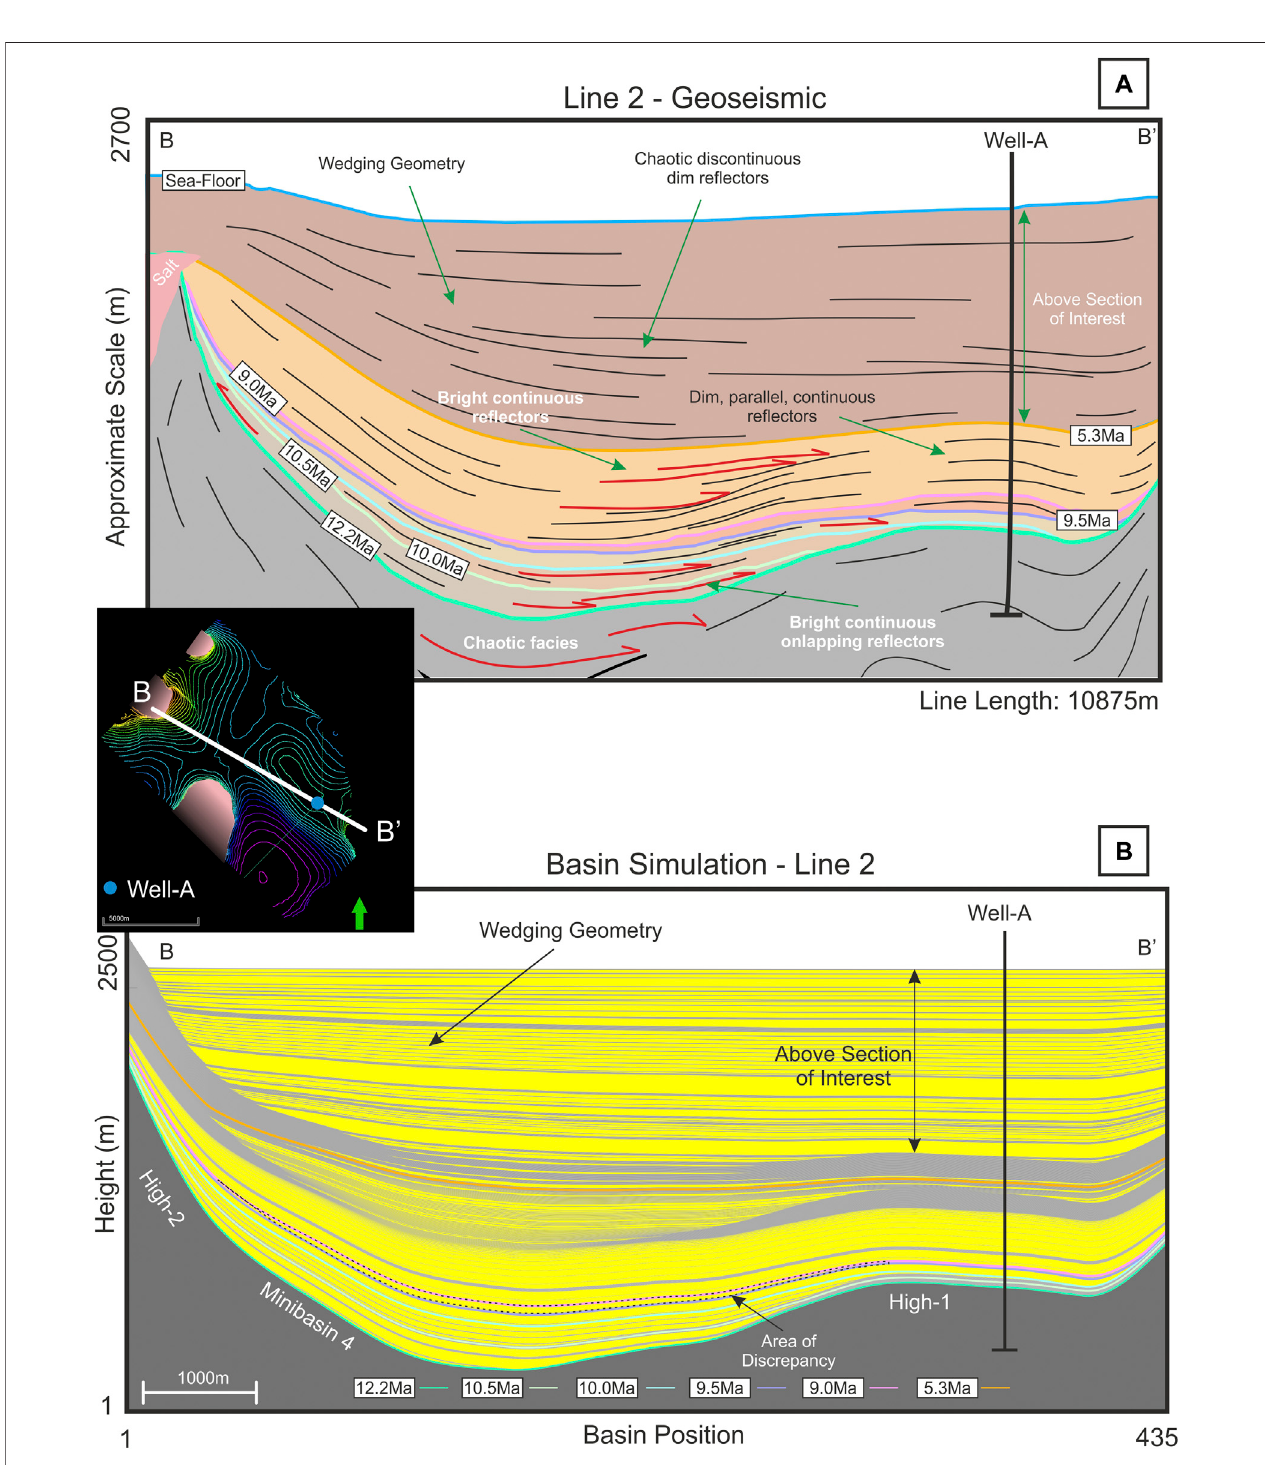
FIGURE7|(A) Geoseismiccross-sectionofLine2.Line2crossesbothHigh-1andHigh-2,withHigh-2containingsalt.Thewedginggeometryseeningeoseismic cross-section is above our area of interest, but is still modelled at a lower resolution. (B) Onlapse-2D fi nal simulation, overall within the section of interest there is a good match between model and the geoseismic. The model is able to match the general form of the basin as well, and major onlapping re fl ectors seen in 8a, occur in the modelled simulation. An area of discrepancy is highlighted within MiniBasin 4.